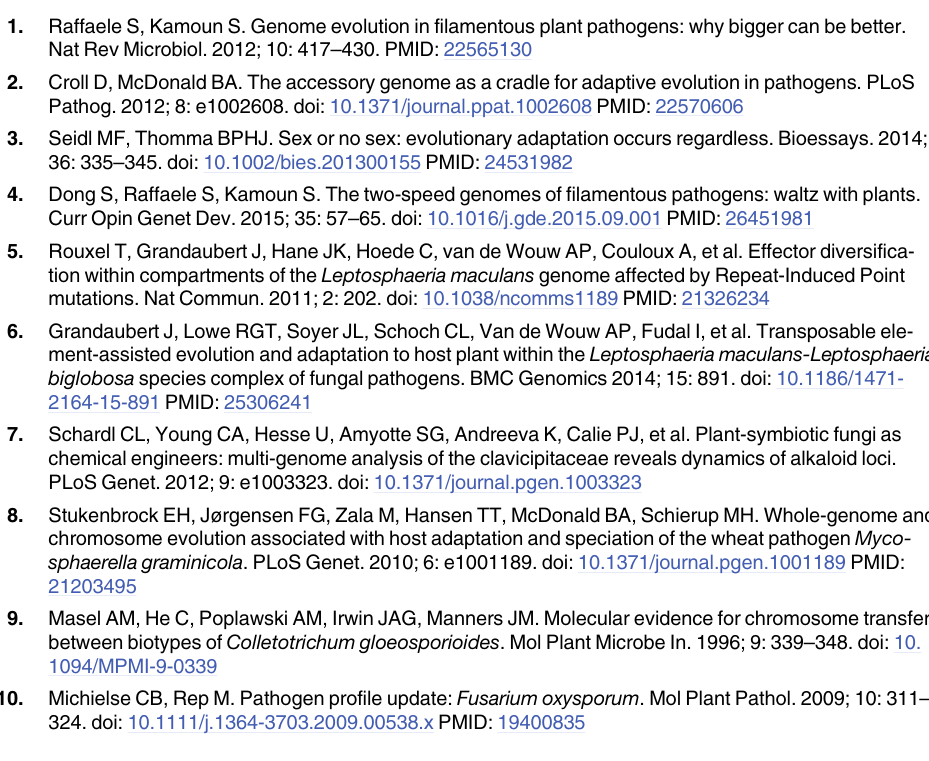
upper left corner. S2 Fig. Depths of coverage for contig mc28.4 by Illumina reads from each of the ten iso- lates. S3 Fig. Depths of coverage for contig mc74.1 by Illumina reads from each of the ten iso- lates. The contig region containing a gene encoding a cytochrome P450 enzyme was present in one F. tucumaniae isolate but not in the other F. tucumaniae